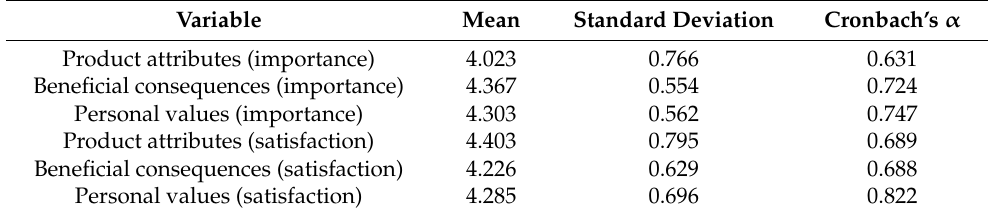
Table 2. Reliability Analysis.